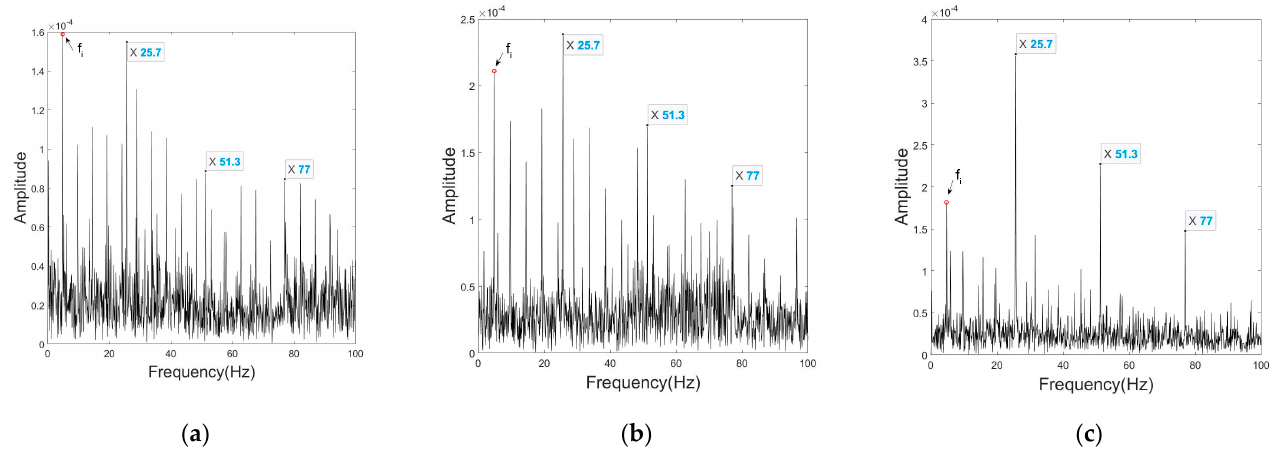
Figure 8. Envelopes under outer race fault condition at 290 rpm of: ( a ) non − processed mono signal; ( b ) UCMA − ESPRIT beamformed signal; ( c ) CPCMA − ESPRIT beamformed signal.